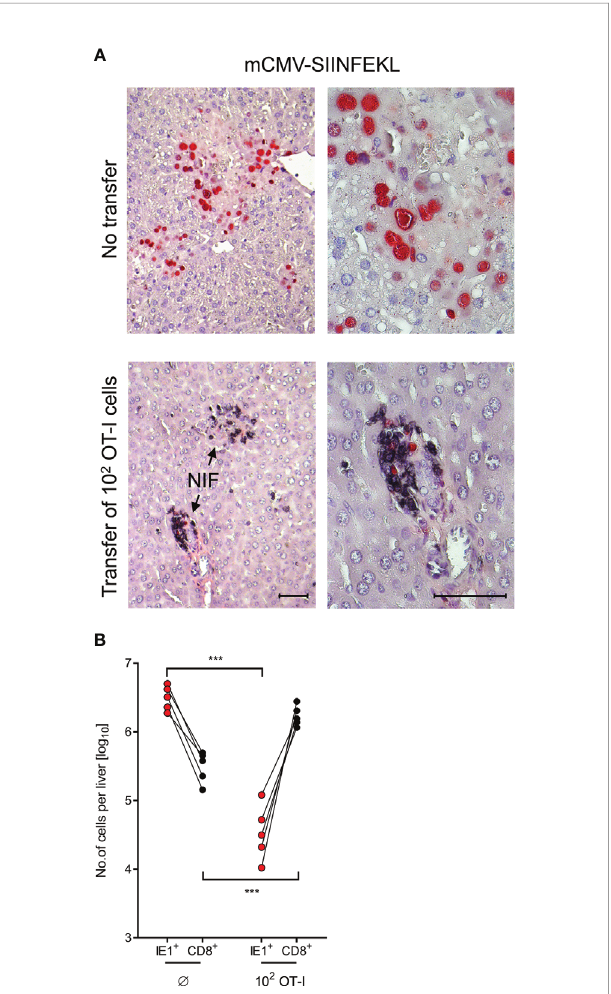
FIGURE 4 | Control of liver infection by tissue in fi ltrating OT-I cells. (A) 2C- IHC images of liver tissue sections, corresponding to groups with no cell transfer and with transfer of 100 OT-I cells in Figure 3. Liver cells, mostly hepatocytes, infected with mCMV-SIINFEKL are identi fi ed by expression of the intranuclear viral protein IE1 (red staining). Residual CD8 + T cells and in fi ltrating OT-I cells are visualized by black staining of the CD8 molecule. (Left images), low-magni fi cation overview. (Right images), resolution to greater detail by higher magni fi cation. Bar markers, 50 m m. (NIF), nodular in fl ammatory foci that represent microanatomical sites where protective OT-I cells aggregate at infected liver cells to con fi ne and resolve the infection. (B) Absolute numbers of infected liver cells (red symbols) and of residual CD8 + T cells (Ø, no transfer control group) as well as tissue-in fi ltrating OT-I cells (both with black symbols) were determined by quantitative 2C-IHC for fi ve mice individually. Paired data are connected by lines. (***) P <